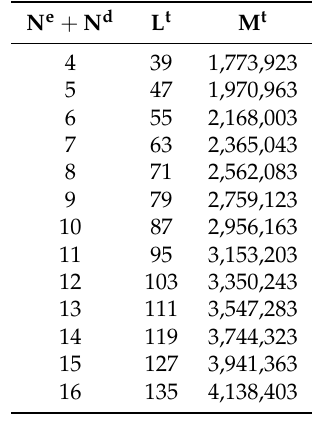
Table 4. Number of layers and parameters when varying the number of blocks ( N e and N d ) in asymmetric structured networks.